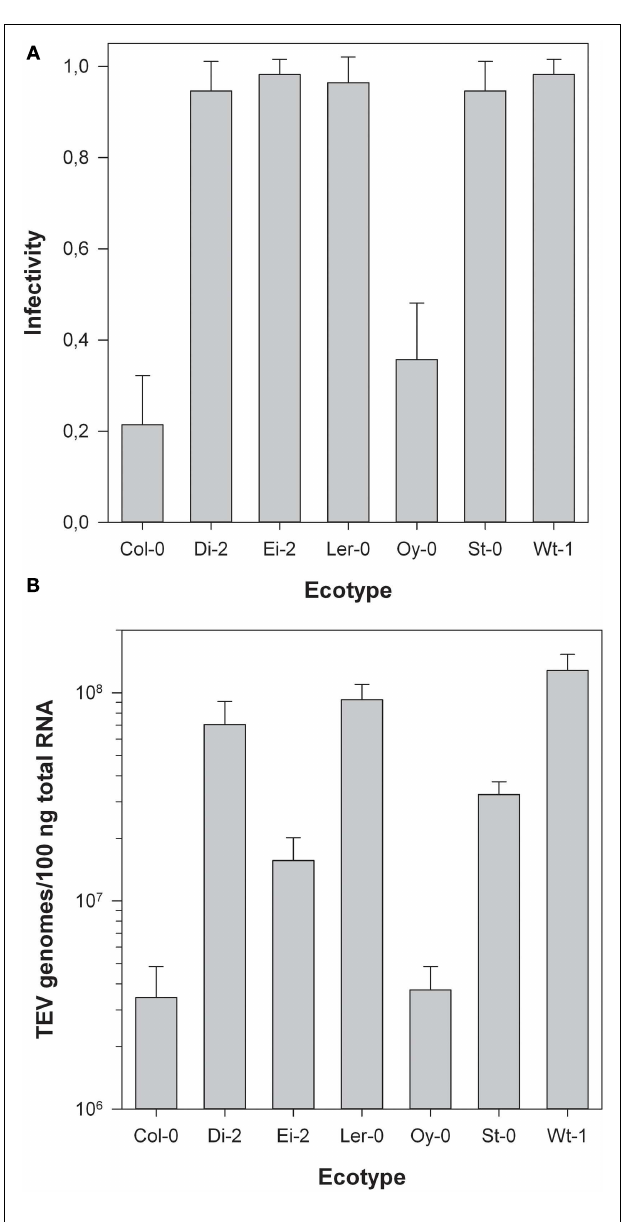
FIGURE 1 | (A) Infectivity ofTEV- At 17b on each ecotype. Error bars represent 95% confidence intervals.The infection was determined by symptoms and confirmed by RT-PCR in plants showing no or mild symptoms. (B) Log viral load ofTEV- At 17b on each ecotype expressed as the content of viral RNA in total RNA extracted from homogeneous sap was determined by RT-qPCR. Error bars represent ± 1 SEM.